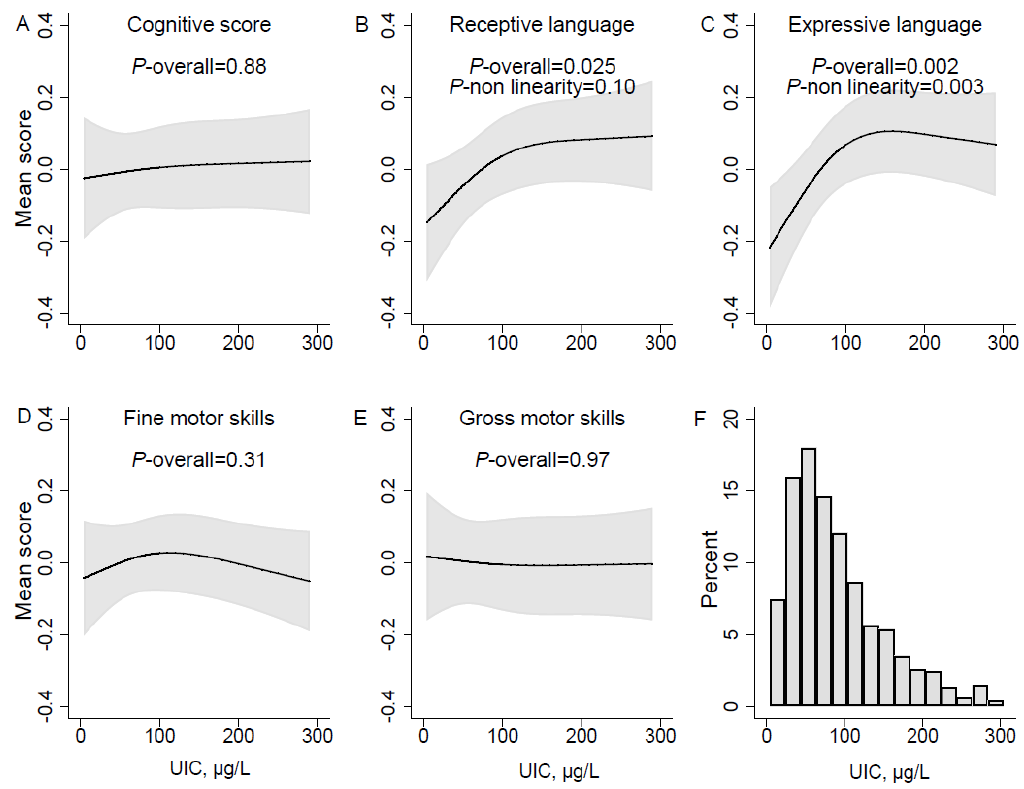
Figure 2. UIC µg/L in pregnancy and mean neurodevelopmental scores estimated in mixed models over sampling occasions at child age 6, 12, and 18 months. Panel A-E represent different neurodevelopmental domains, ( A) Cognitive score; ( B) Receptive language; ( C ) Expressive language; (D ) Fine motor skills; ( E) Gross motor skills. The histogram in panel ( F) illustrates the distribution of urinary iodine concentration (µg/L) in the population. Associations were modelled flexibly by use of restricted cubic splines (three knot positions, at percentiles 10, 50, and 90 of UIC). Solid lines represent estimated means across measurement occasions, and the grey areas illustrate 95% robust confidence intervals (CI). P-values for the overall associations of UIC and outcomes were calculated by testing all spline-coefficients equal to zero, and non-linearity by testing the second spline coefficient equal to zero. Models are adjusted for maternal age, prepregnancy BMI, marital status, education, parity, daily smoking in pregnancy, and child sex.